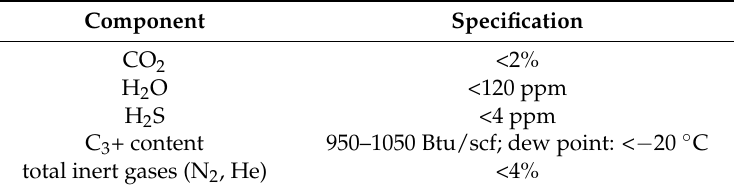
Table 3. Composition specifications for natural gas delivery to the U.S. national pipeline grid [10].